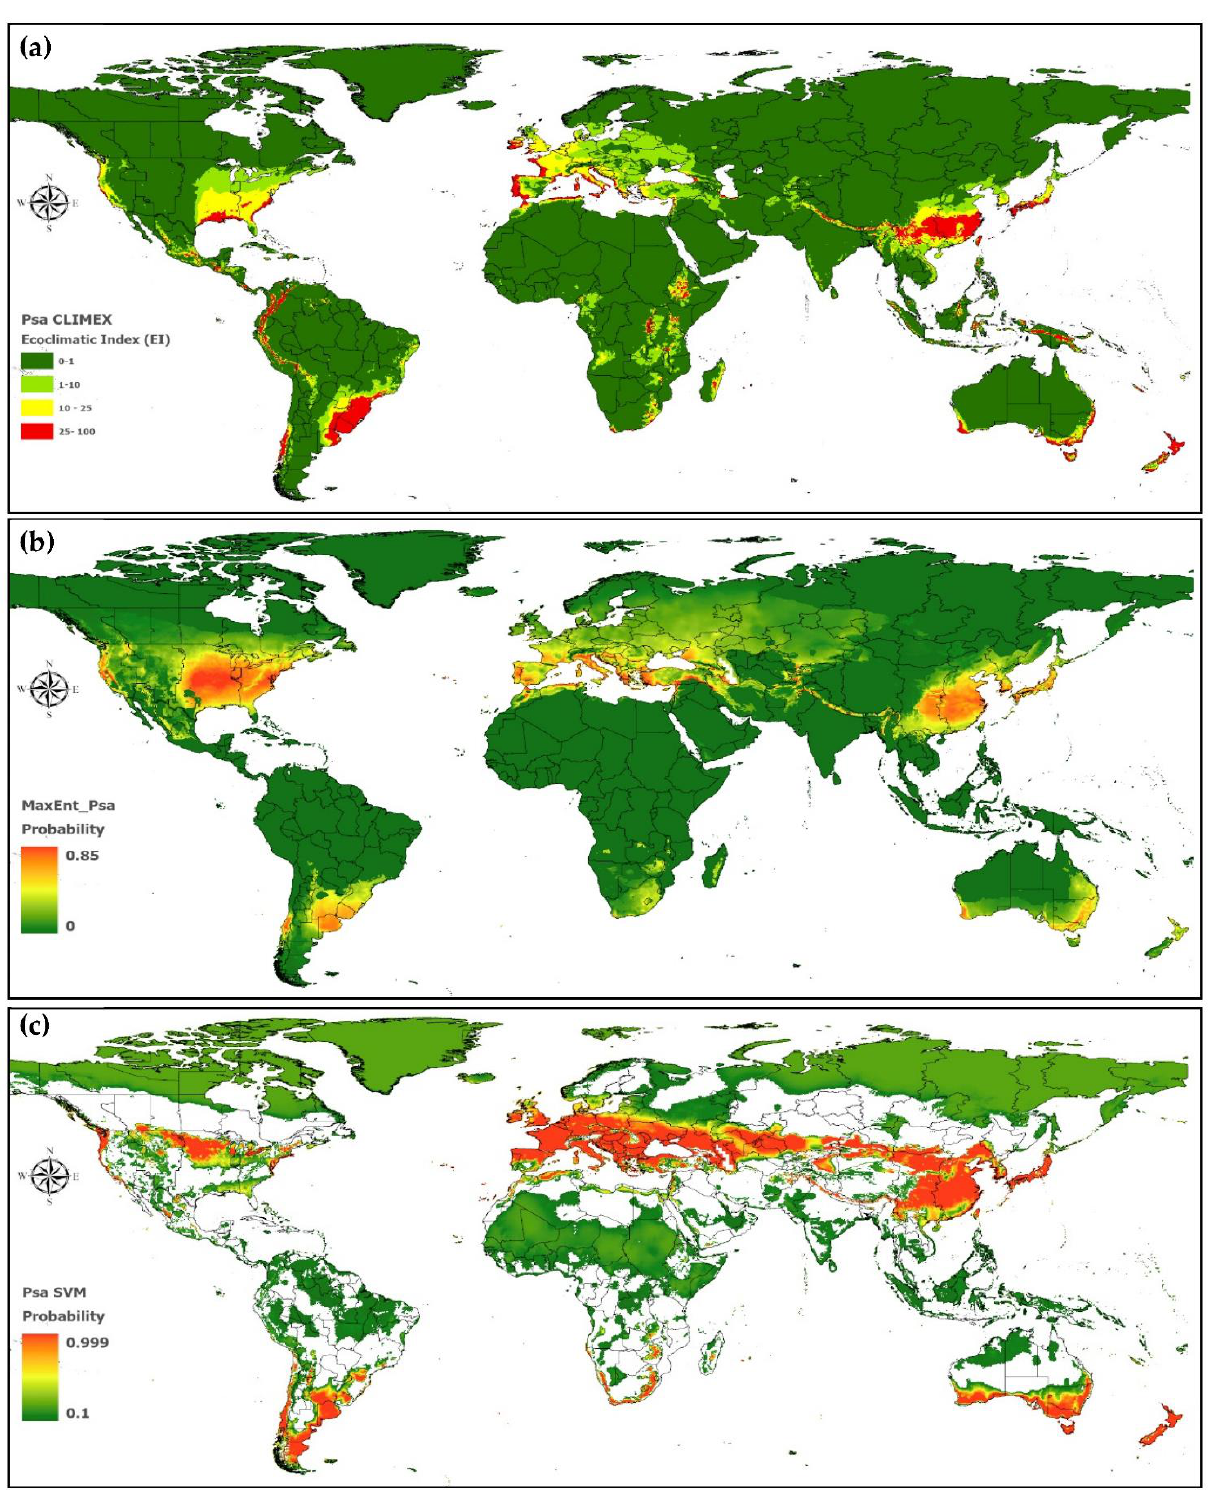
Figure 4. Potential climate suitability of kiwifruit bacterial canker disease at global scale projected by ( a ) CLIMEX, ( b ) MaxEnt, ( c ) support vector machine (SVM from multi-model framework).